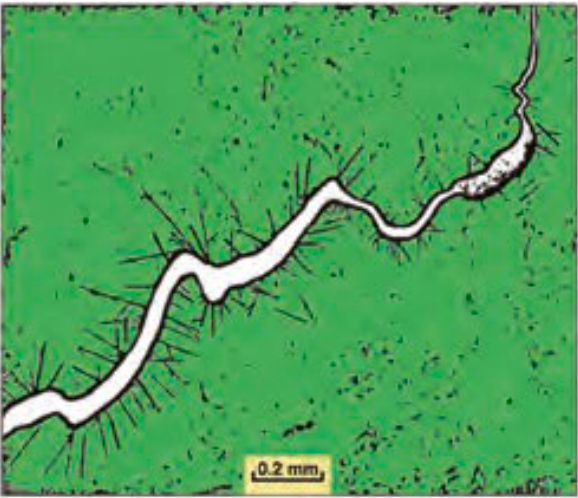
Figure 78. Round a stylolitic quartz vein from the Sokoman Iron Formation, Lac Helluva, Labrador, Dimroth and Chauvel 17 (1973, p. 122) show minnesotaite needles nucleated at right angles to the sinuous convolutions of the vein. The vein, by facilitating water release, has nucleated the crystallisation and it was clearly emplaced prior to the time the minnesotaite crystallised from its surrounding hydrous ferromagnesian